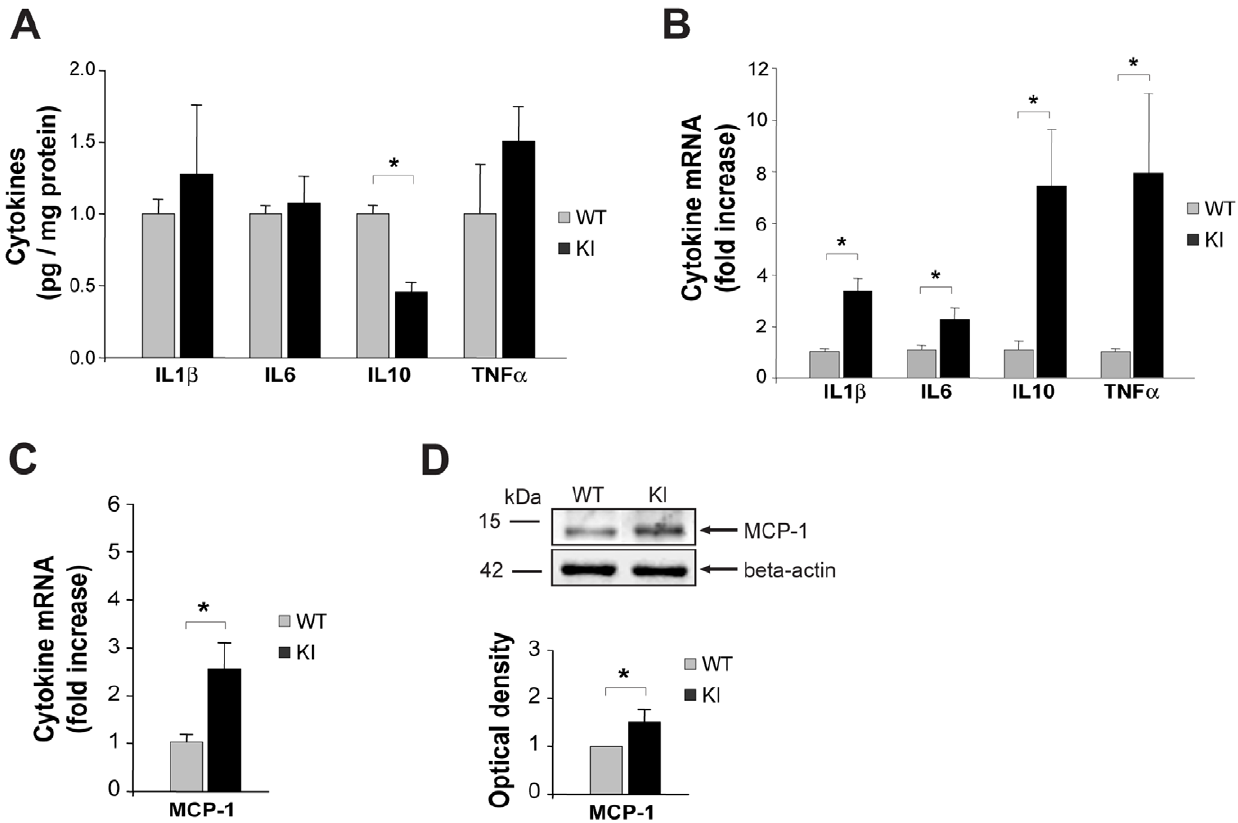
Figure 4. Expression of inflammatory mediators in WT and R192Q KI trigeminal ganglia under basal conditions. A , Histograms quantify IL1 b , IL6, IL10 and TNF a cytokine protein levels from WT or R192Q KI ganglia; n =4 WT and 4 KI mice; data were normalized on total protein content, and represented as fraction of WT. * p , 0.001. B , Real-time RT-PCR experiments quantify IL1 b , IL6, IL10 and TNF a mRNA levels in WT and R192Q KI trigeminal ganglia. PCR data were normalized with respect to corresponding GAPDH and b -Tubulin housekeeping gene expression and expressed as fraction of WT; n =4 WT and 4 KI mice; * p , 0.05. C , Real-time RT-PCR experiments quantify MCP-1 mRNA levels in WT and R192Q KI trigeminal ganglia (expressed as in B ); n =4 WT and 4 KI mice; * p , 0.05. D , Representative western blot experiment of WT or R192Q KI trigeminal ganglia extracts immuno-probed with anti-MCP-1 antibodies. Actin levels were used as loading control. Histograms quantify the differences. n =3; * p , 0.05.